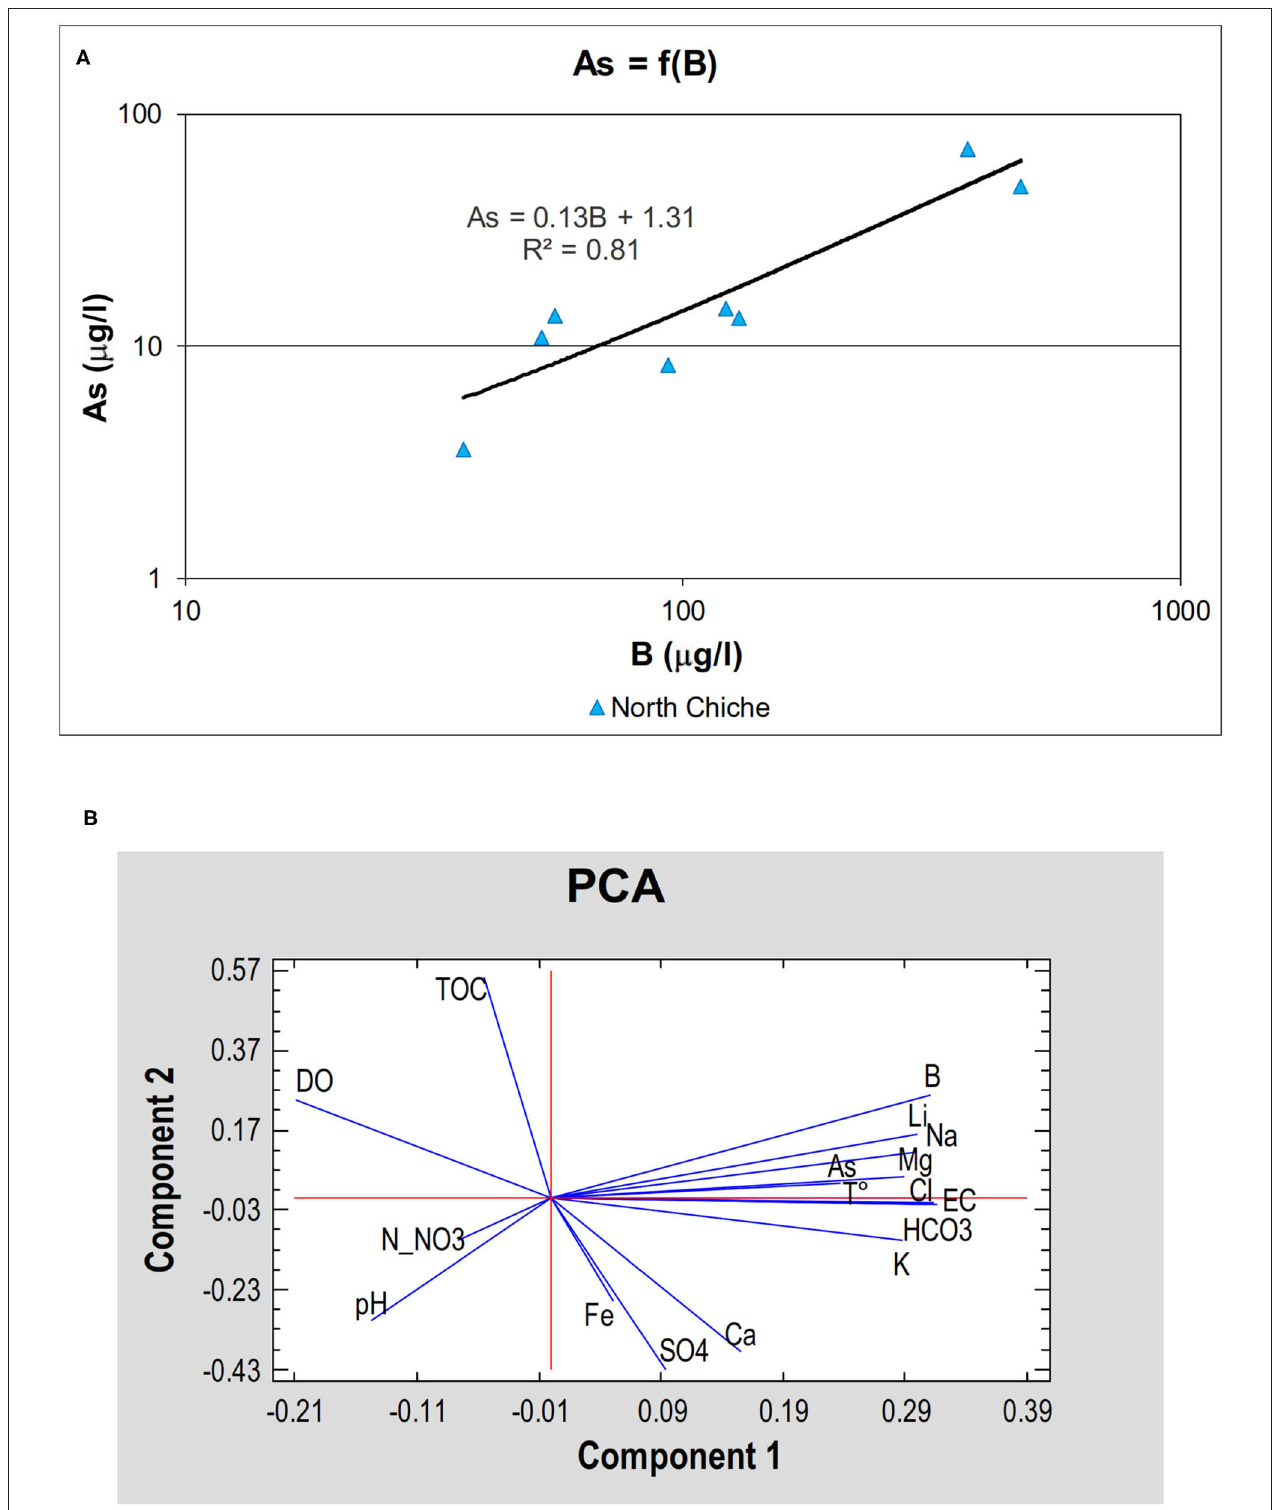
FIGURE 10 | Chemical trends and correlations. (A) Log-Log correlation between As and B in the North Chiche aquifer ( r ² = 81%). (B) Principal Components Analysis (PCA). All elements were expressed in µ g.l − 1 , T ◦ in ◦ C, Electrical Conductivity (EC) in µ S.cm − 1 , Total Organic Carbon (TOC) and Dissolved Oxygen in mg.l − 1 .